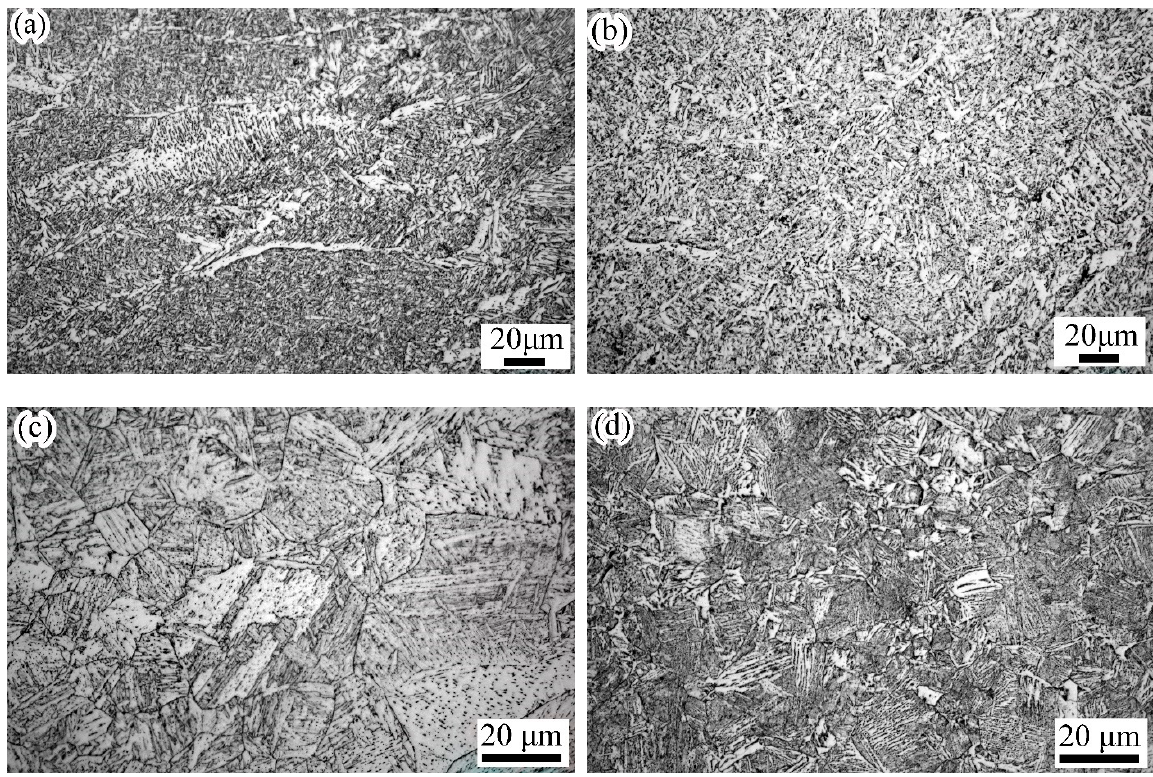
Figure 12. Microstructure: ( a ) junctional zone among welding pass, ( b ) weld zone, ( c ) HAZ located at X80 pipe, ( d ) HAZ located at Q345B pipe.